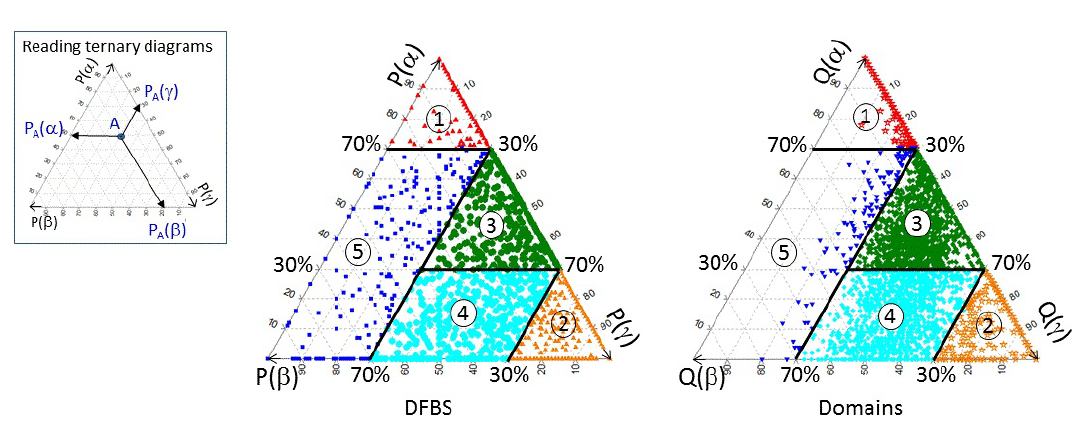
Figure 1. Ternary diagrams representing the overall distribution of the 4001 DFBSs (left diagram) and of the corresponding 4001 domain surfaces (right diagram) according to their per cent SSE propensities, P ( s ) and Q ( s ) , respectively. Dots are coloured as red: class 1; orange: class 2; green: class 3; cyan: class 4; blue: class 5. Heavy lines indicate our chosen SSE class boundaries. The box on the left illustrates how to read the diagram.